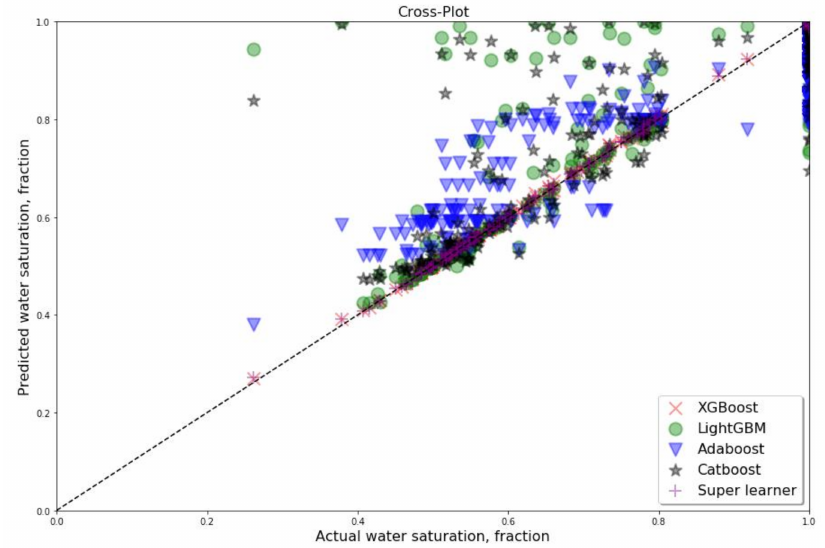
Figure A5. Cross plot for water saturation prediction results by different algorithms (Well 2).